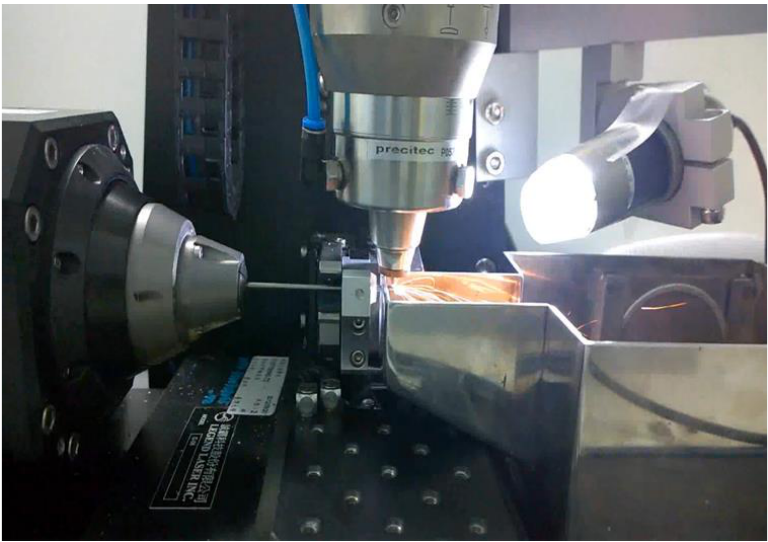
Figure 5. Stent design pattern cut onto a 2.0 mm hypotube by laser-cutting